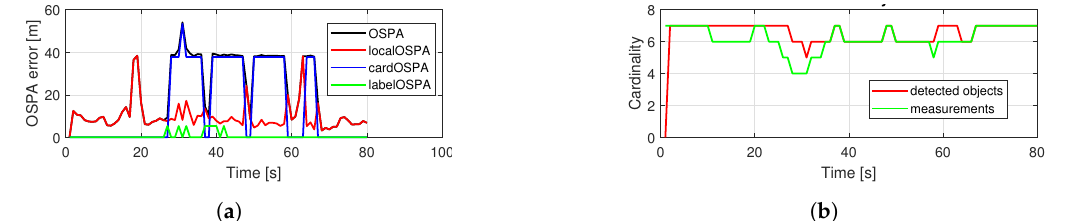
Figure 5. Performance of a single simulation with crossing trajectories using the proposed PHD filter. OSPA error ( a ), cardinality statistics ( b